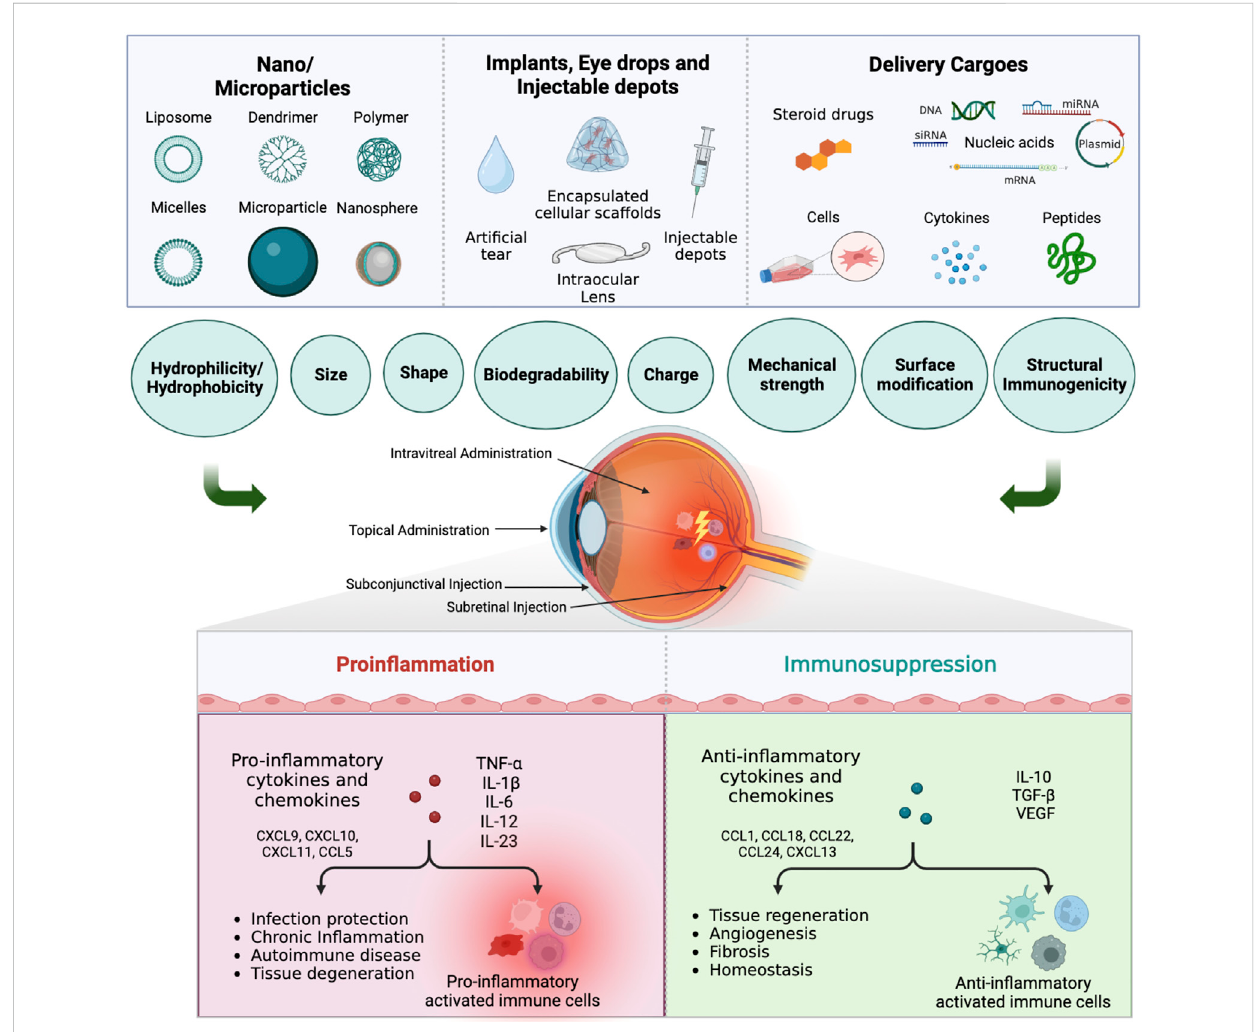
FIGURE 1 Immunomodulatory drug delivery systems for ocular innate immune cells immunotherapy. Biomaterials such as nanoparticles, microparticles, implants, eye drops, and injectable depots, with or without immunomodulatory cargoes, can be used to treat ocular diseases via different administration routes.Dependingonthephysiochemicalproperties,thebiomaterialscanpromoteorsuppresstheresponsefromproin fl ammatoryinnateimmunecells, which will in turn affect the therapeutic outcome (Created in